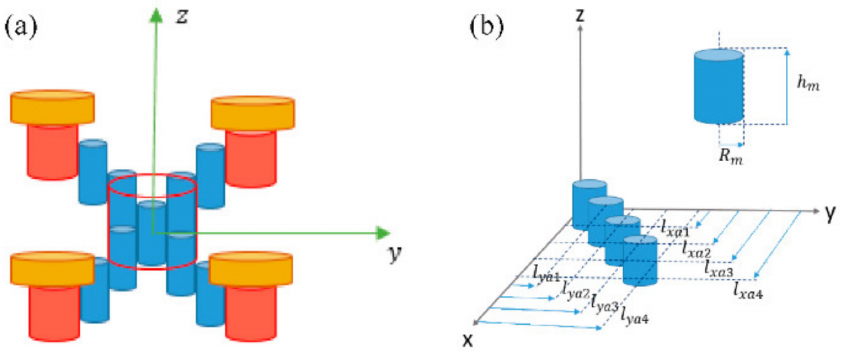
Figure 2. Inertial model of the quadcopter: ( a ) full model, ( b )